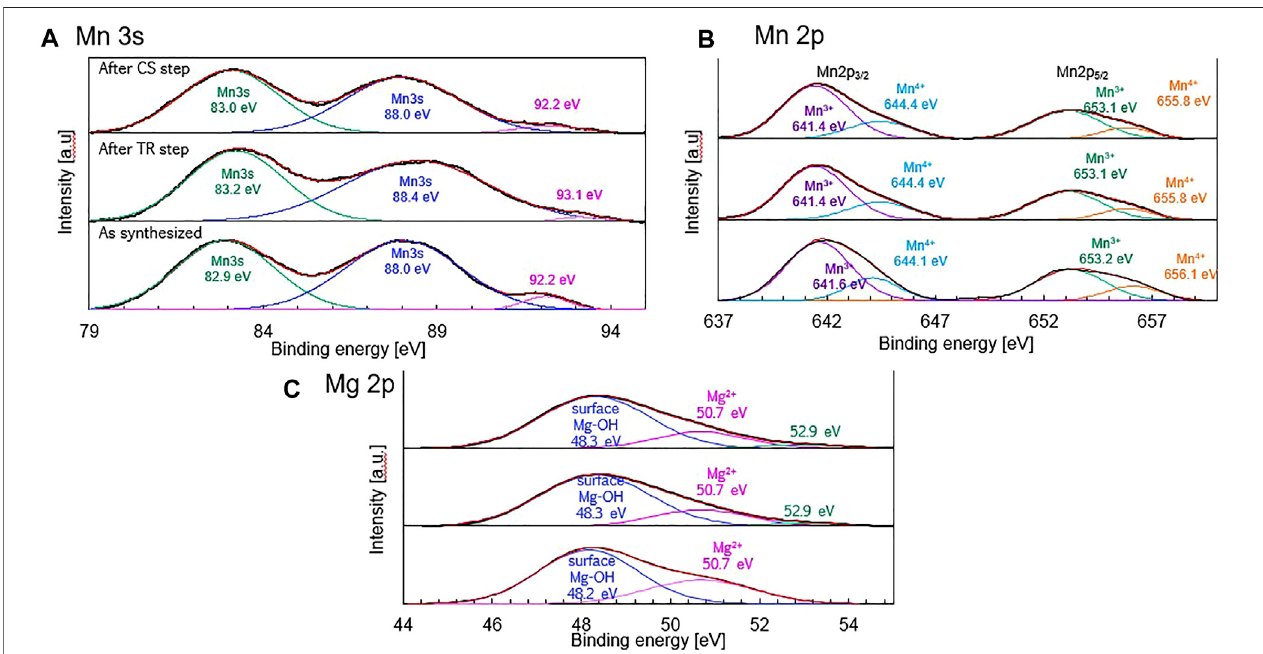
FIGURE 11 | (A) Mn 3s, (B) Mn 2p, and (C) Mg 2p x-ray photoelectron spectra with peak deconvolutions of the synthesized sample (as-prepared sample), thermally-reduced sample obtained after the TR step, and the oxidized sample obtained after the CS